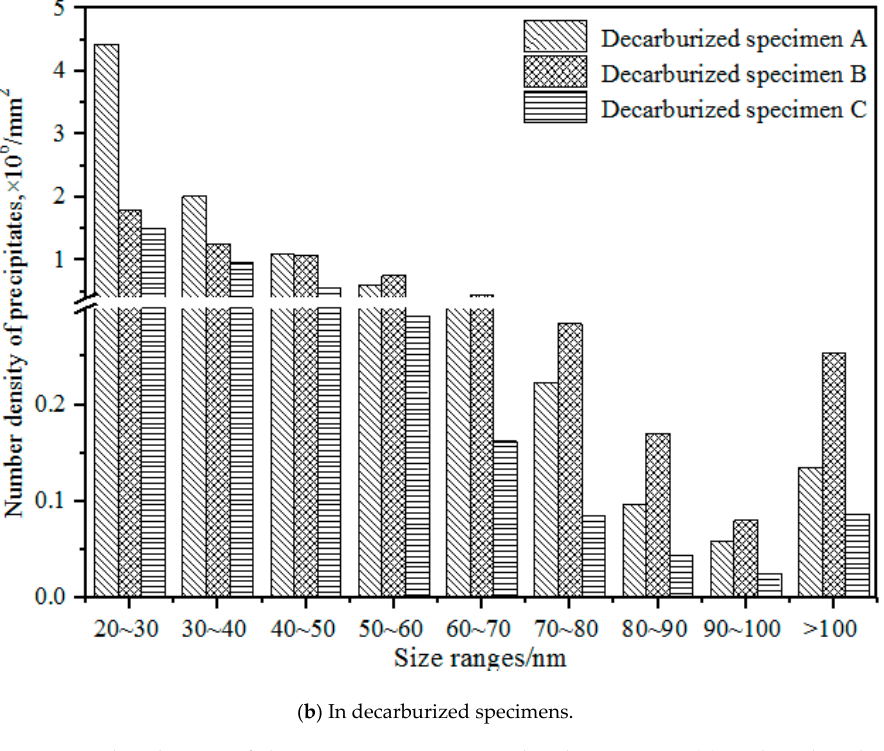
Figure 4. Sizes distribution of the precipitates in normalized specimens ( a ) and in decarburized specimens ( b ).